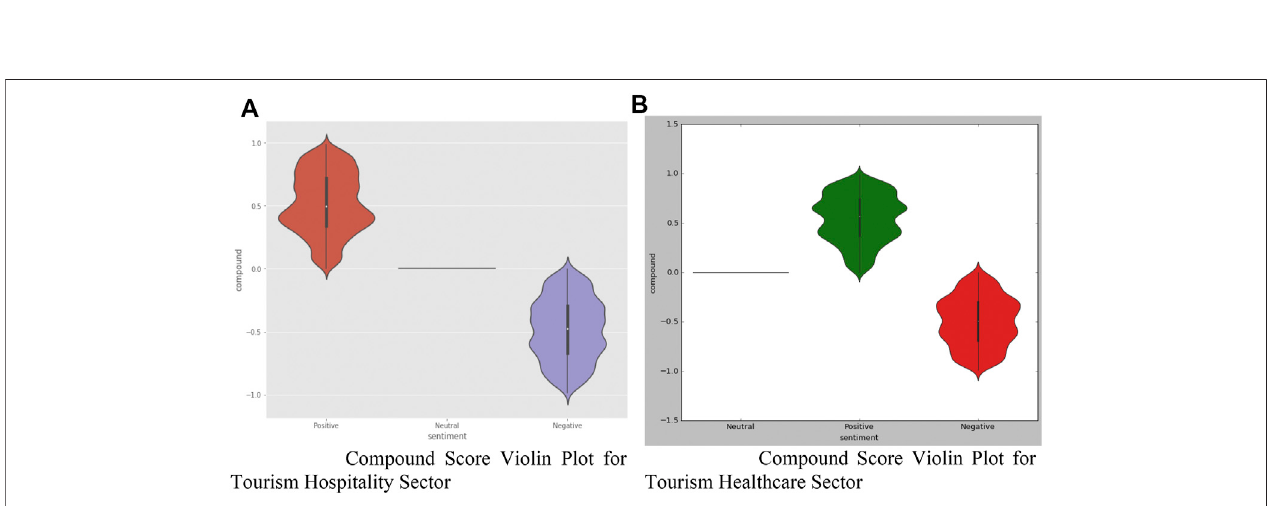
FIGURE 7 | (A) Compound score violin plot for tourism hospitality sector (B) Compound score violin plot for tourism healthcare sector.